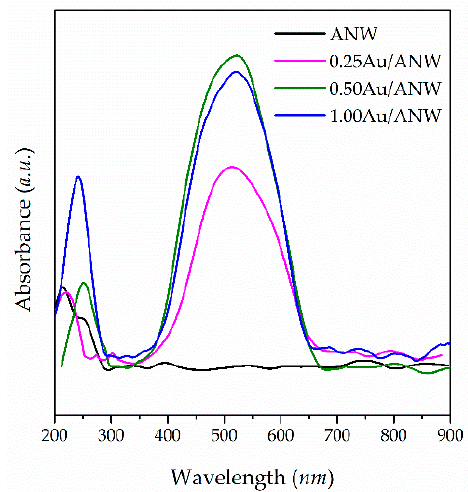
Figure 4. UV − vis − NIR di ff use reflectance spectroscopy (DRS) of ANW support and (x)Au / ANW catalysts.